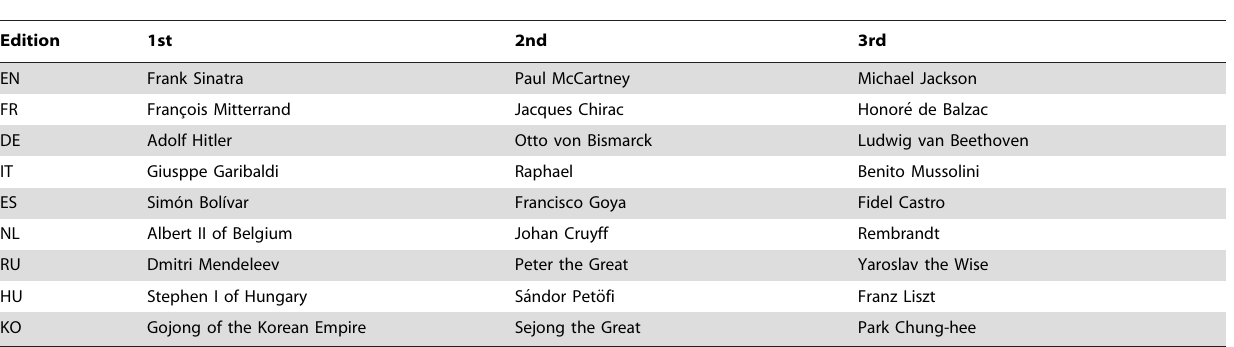
Table 6. List of local heroes by 2DRank for each Wikipedia edition.